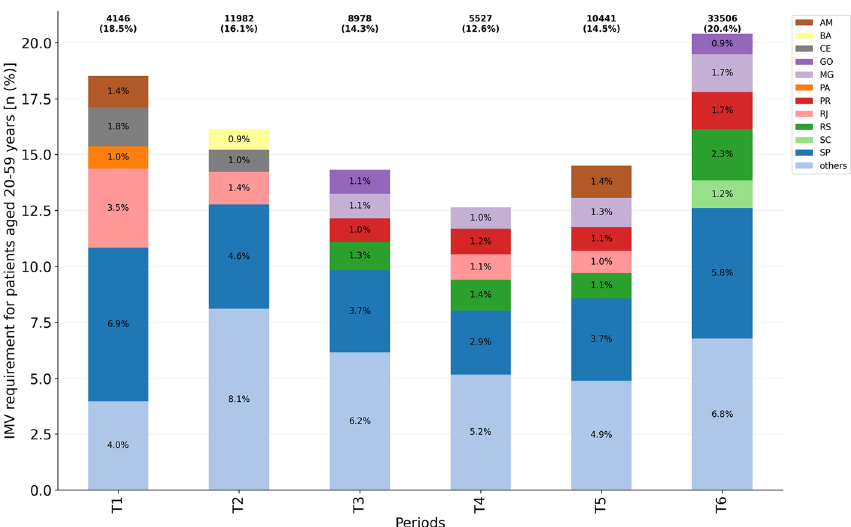
Figure 5. IMV requirement for patients aged 20–59 years per considered period ( n = 74,580 ). Federative units showing proportions ≥ 0.9 were highlighted while ‘others’ accounts for the grouping of those presenting a proportion < 0.9